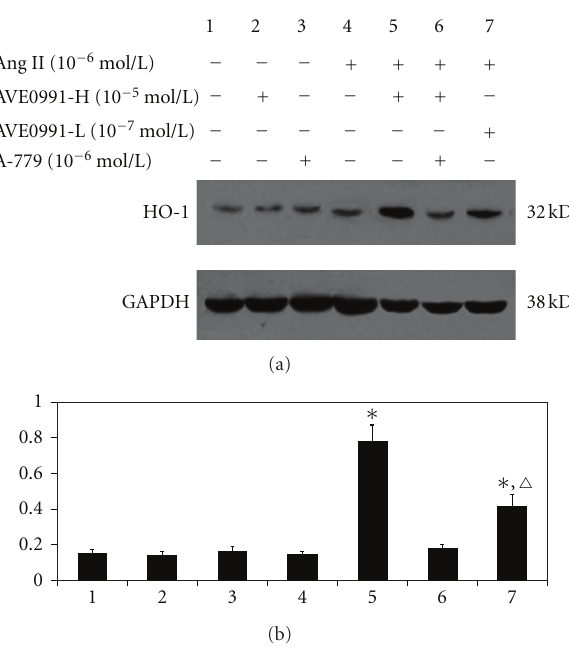
Figure 8: The e ff ect of AVE0991 on HO-1 protein expression in VSMCs that were induced by Ang II. ∗ P < 0 . 01 versus control group; (cid:5) P < 0 . 01 versus Ang II + AVE0991-H group; n = 8.